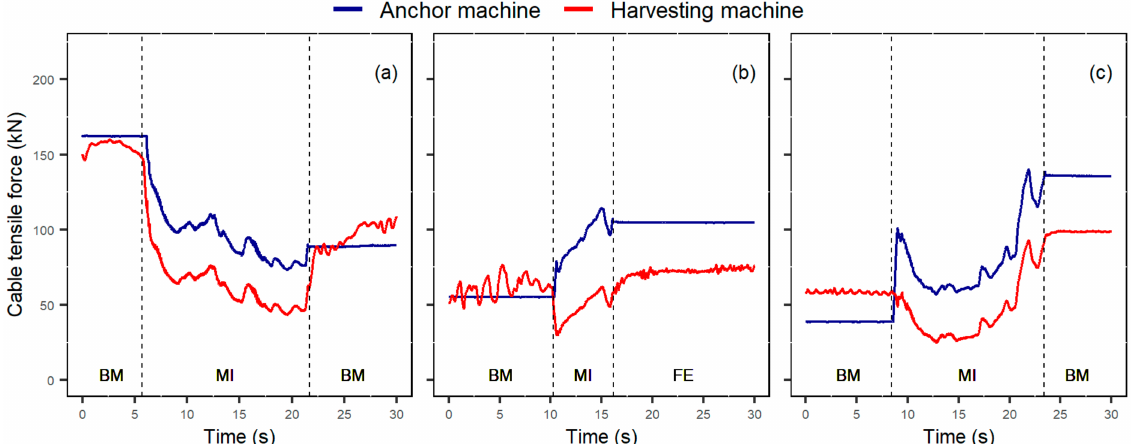
Figure 6. Example of significant events recorded during moving-in: ( a ) Drop in cable tensile forces at both the harvesting and anchor machine; ( b ) Drop in the cable tensile forces at the harvesting machine and increment at the anchor machine; ( c ) Similar to b, but with evidence of shifting to high displacement in the winch drive motor. FE, felling; BM, other-boom- movements; and MI,